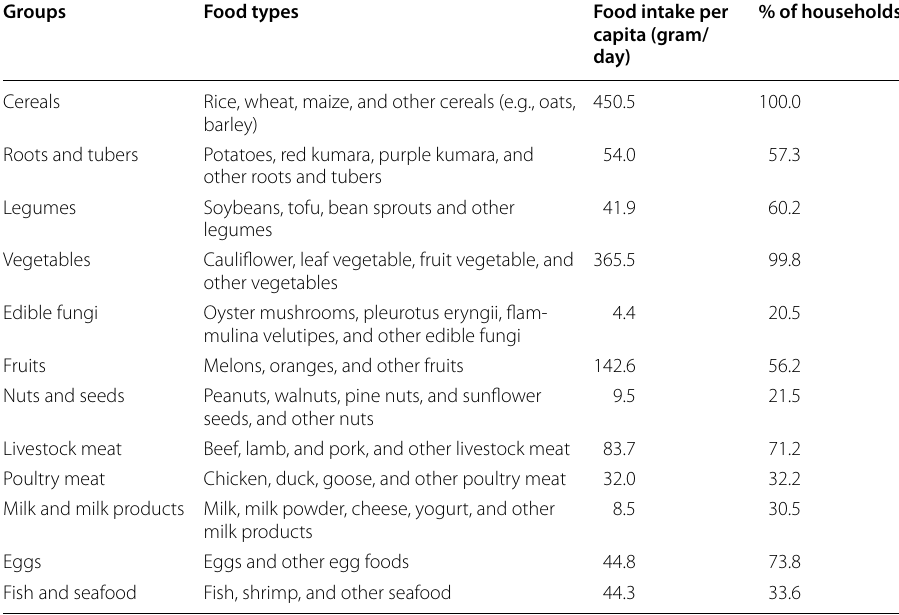
Table 2 Descriptive statistics of food groups that consumed by households Groups Food